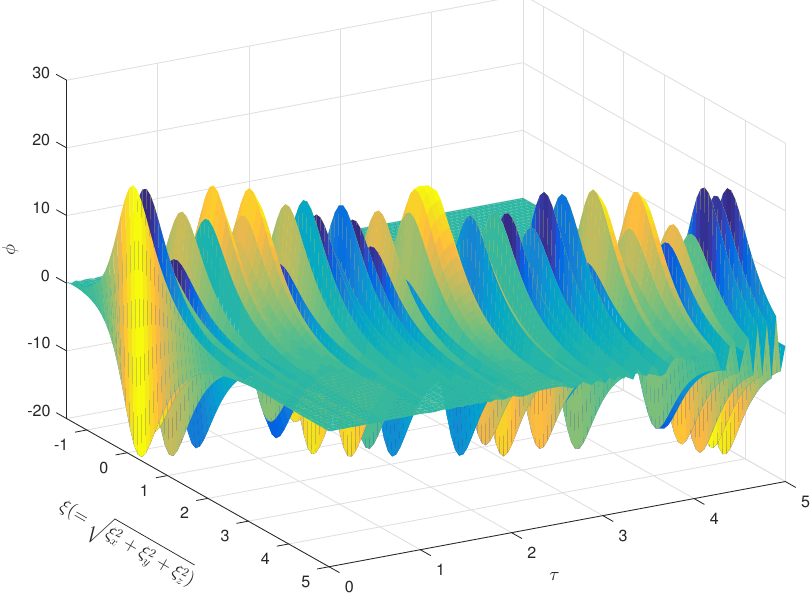
(cid:113) ξ 2 x + ξ 2 y + ξ 2 z .